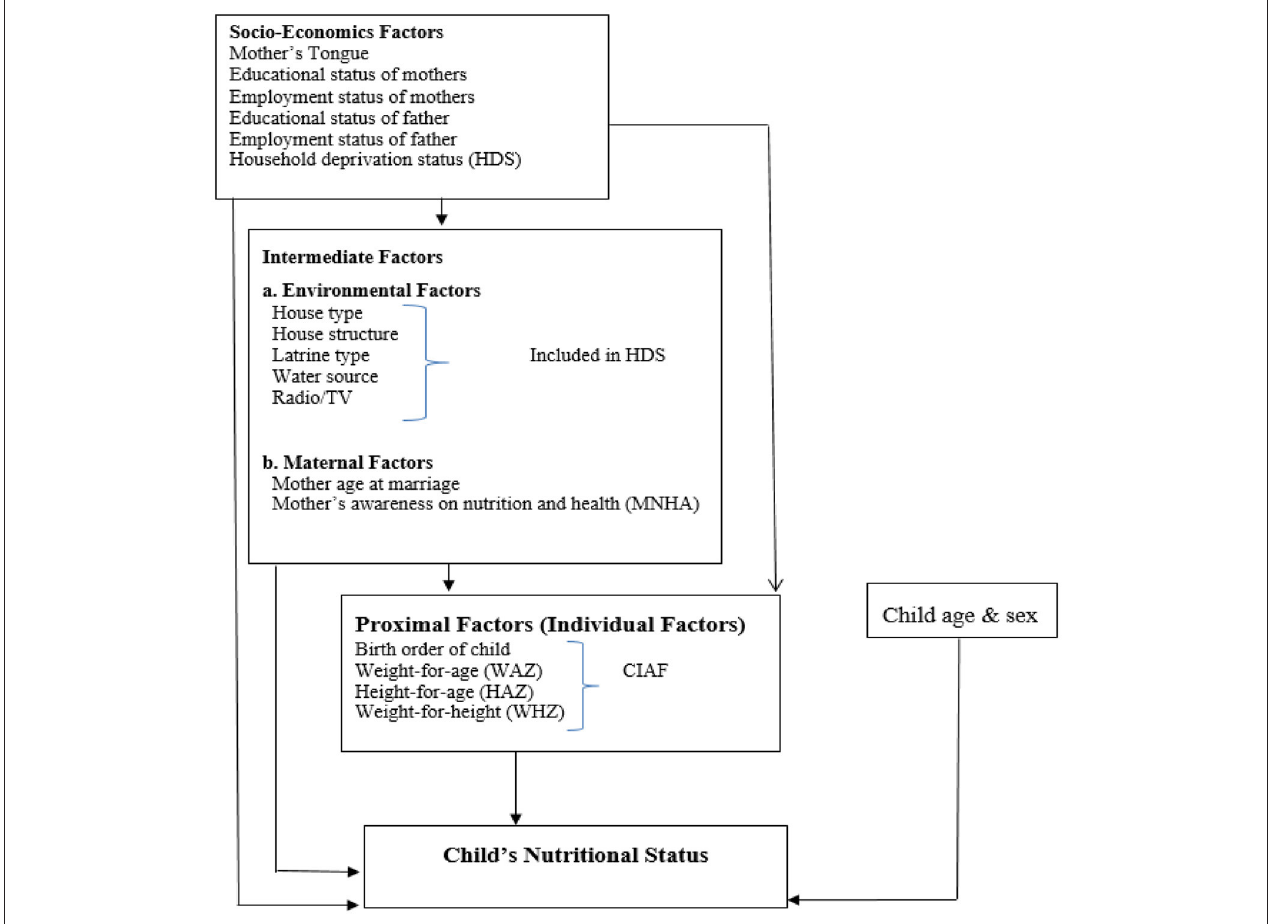
FIGURE 1 | Conceptual framework for determinants of child malnutrition. Victora et al. (21).